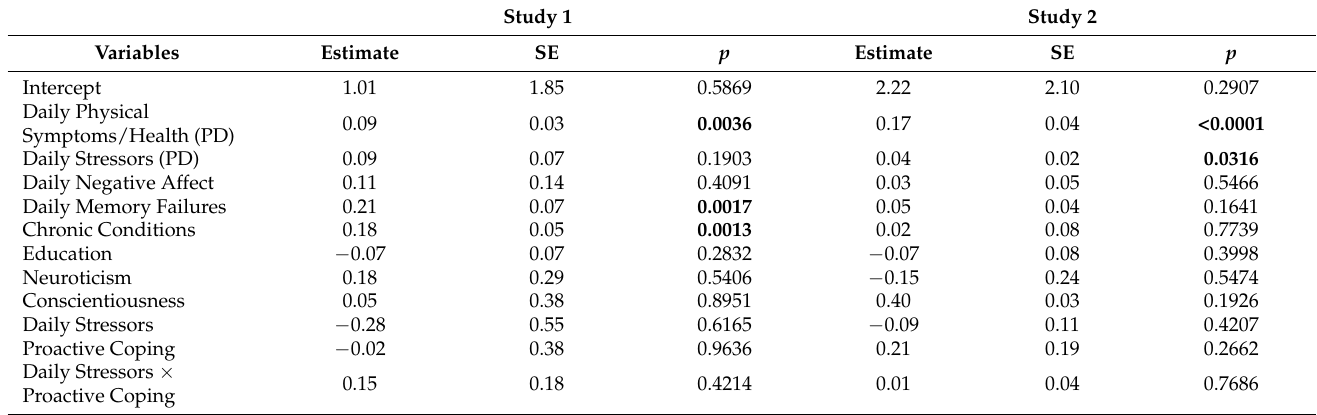
Table 5. Older Adult Model.